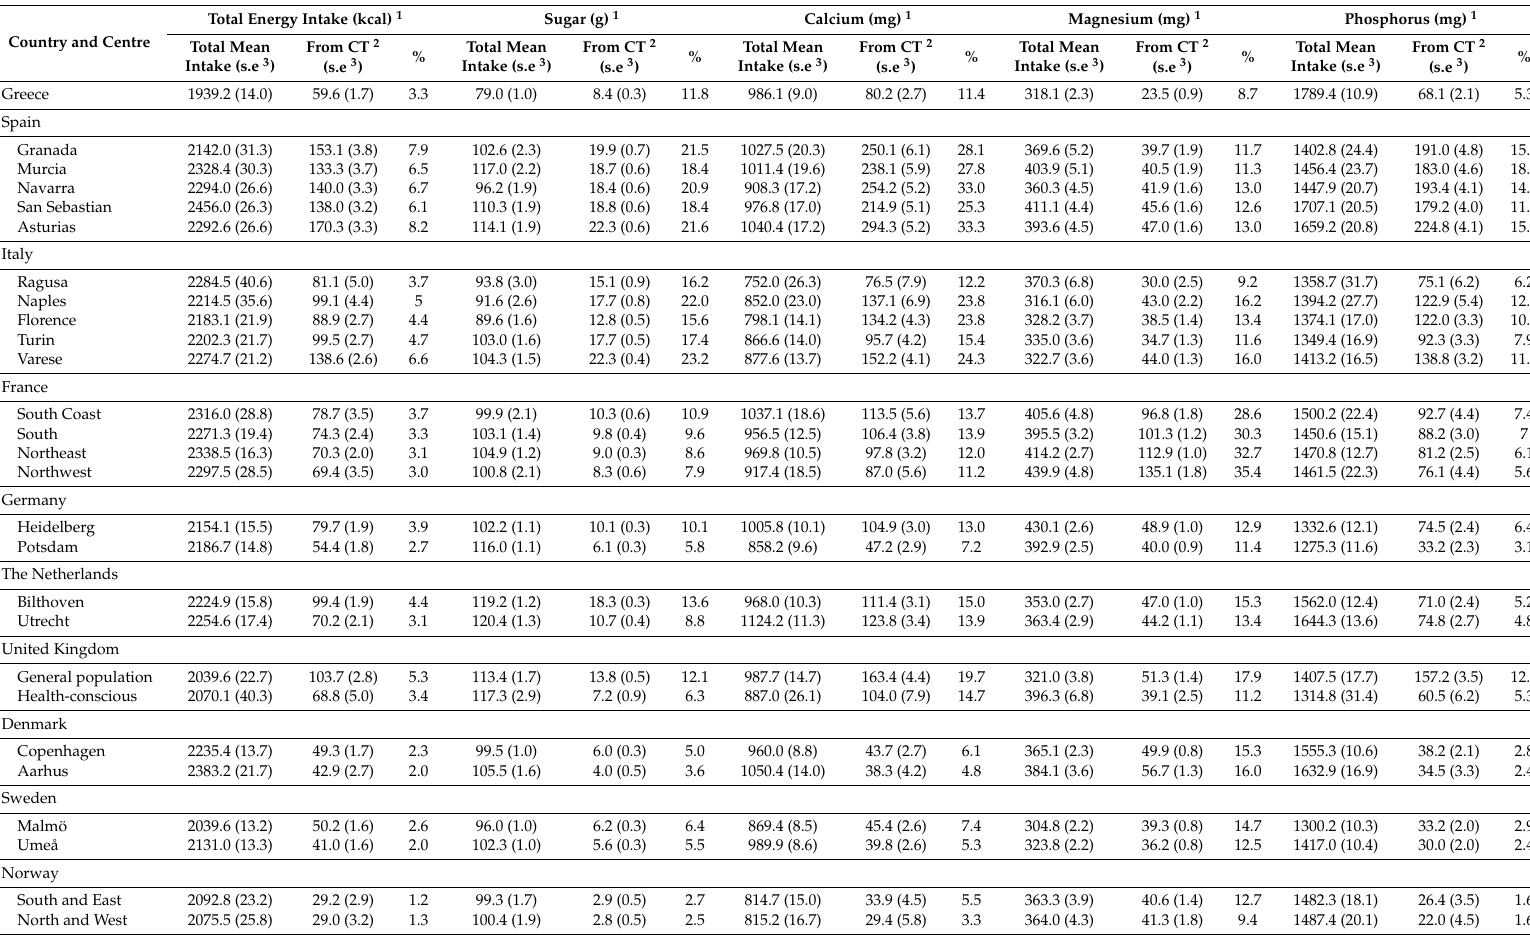
Table 5. Total mean intake of energy and selected nutrients, amount of energy and selected nutrients from coffee and tea, and percentage contribution of coffee and tea to the total mean intake of energy and selected nutrients in the EPIC calibration study population based on 24-H Dietary Recall, by center ordered from south to north.